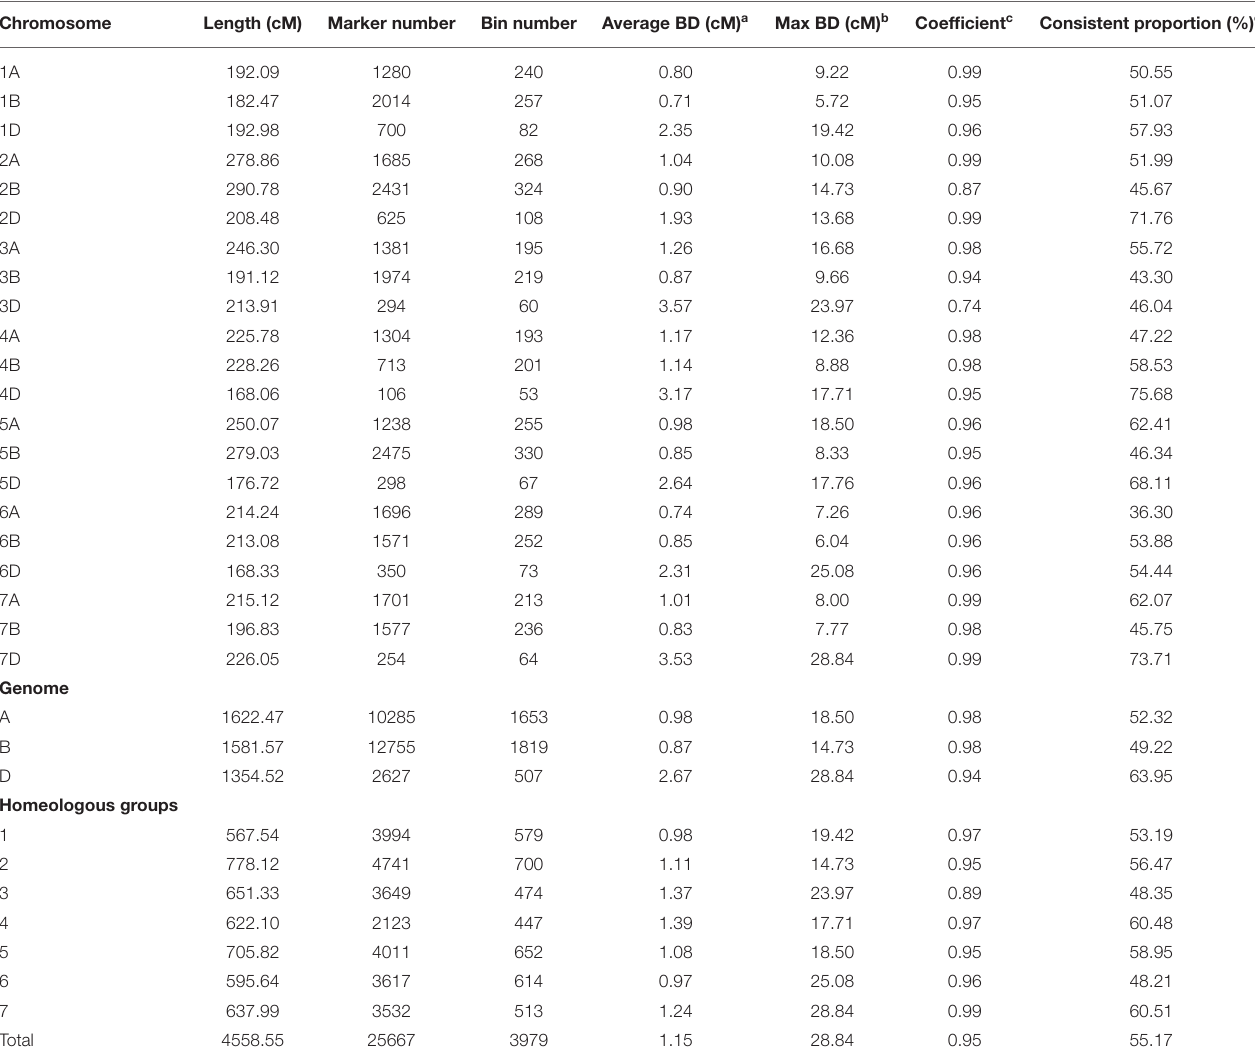
TABLE 2 | Characteristics of the consensus genetic map constructed from the three RIL populations, DS, GZ, and ZC. Chromosome Length